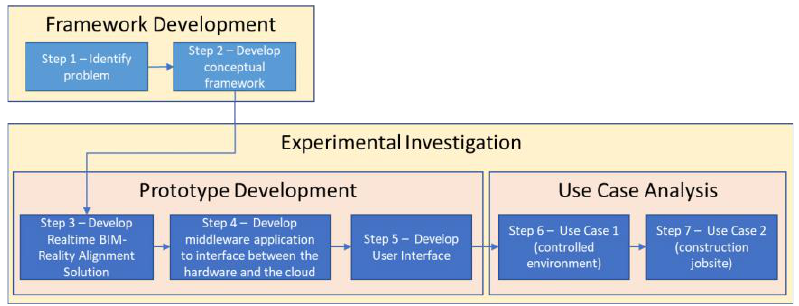
Figure 1. Research